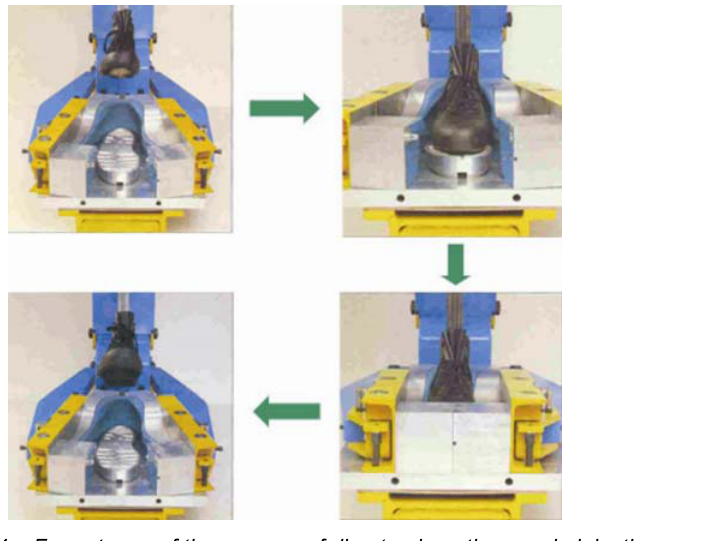
Figure 14 – Four stages of the process of direct polyurethane sole injection onto the boot